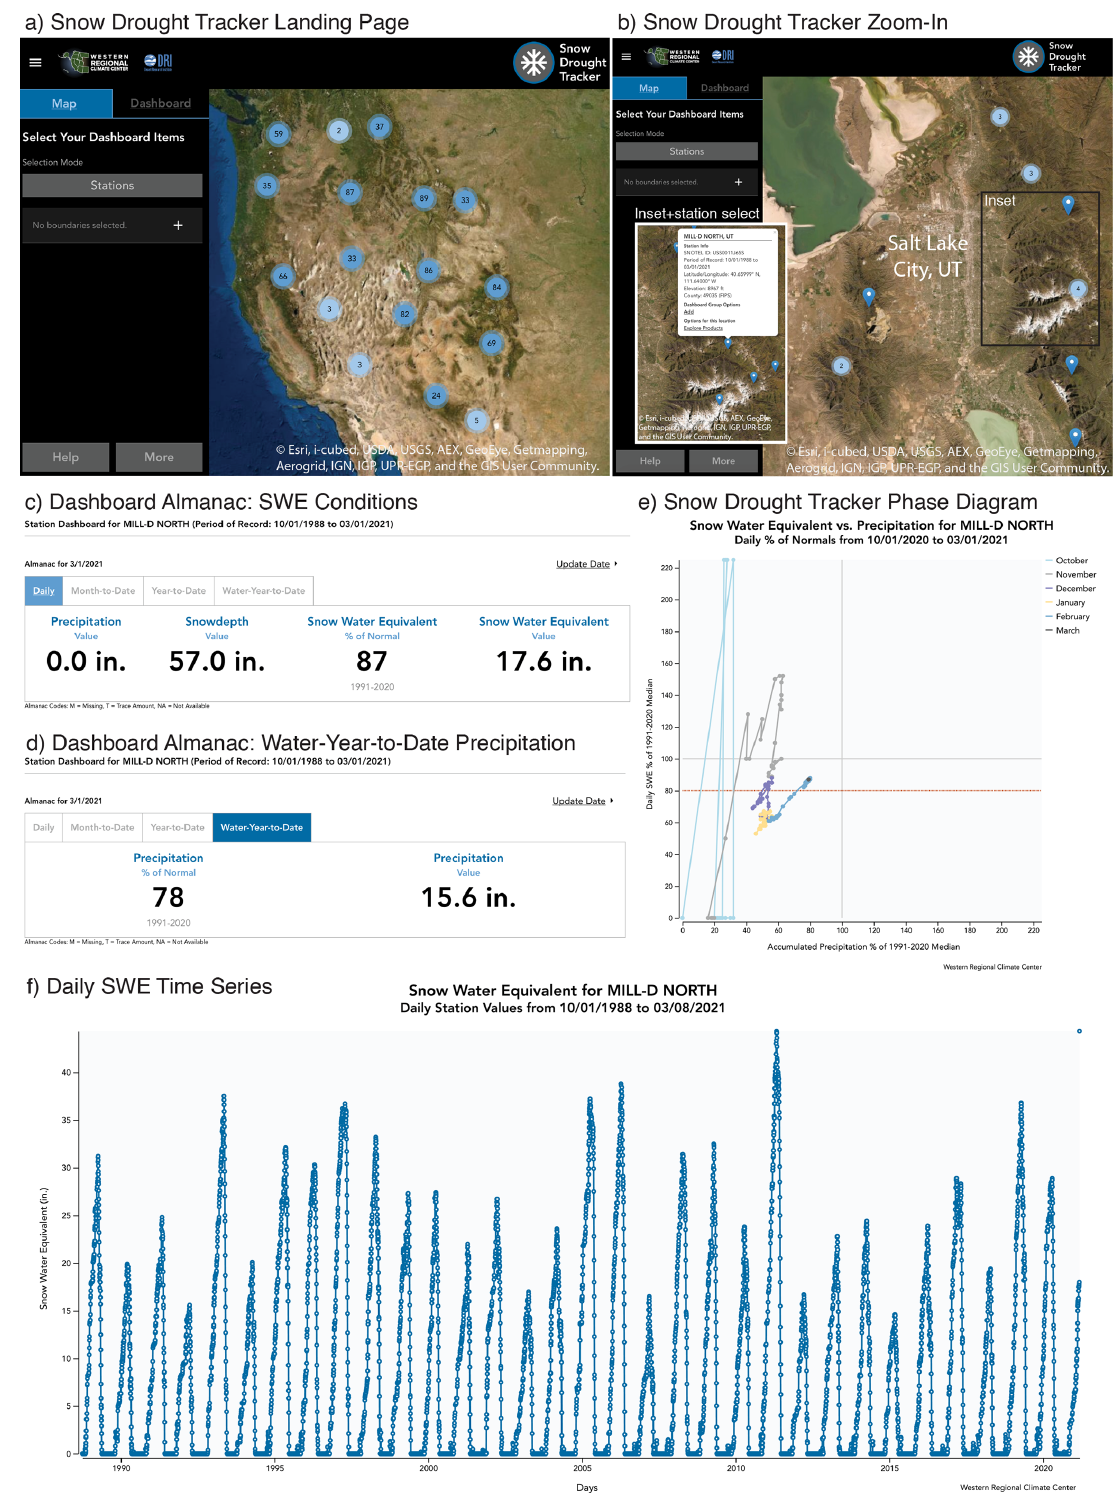
Figure 9. Screenshots from the Western Regional Climate Center (WRCC)’s beta snow drought tracker. (a) Dashboard landing page. (b) Ex- ample screenshot assessing a station in a region of interest (inset). (c) Daily information tab from the Almanac. (d) Water-year-to-date Almanac tab. (e) Real-time phase diagram for water year 2021. (f) Daily snow water equivalent (SWE) time series for the period of record. Basemaps in (a) and (b) utilize ArcGIS ® Online World Imagery by Esri. ArcGIS ® is the intellectual property of Esri and is used herein under license. © Esri. All rights reserved. For more information about Esri ® software, please visit http://www.esri.com (last access: 1 June 2021). https://doi.org/10.5194/nhess-22-869-2022 Nat. Hazards Earth Syst. Sci., 22, 869–890,